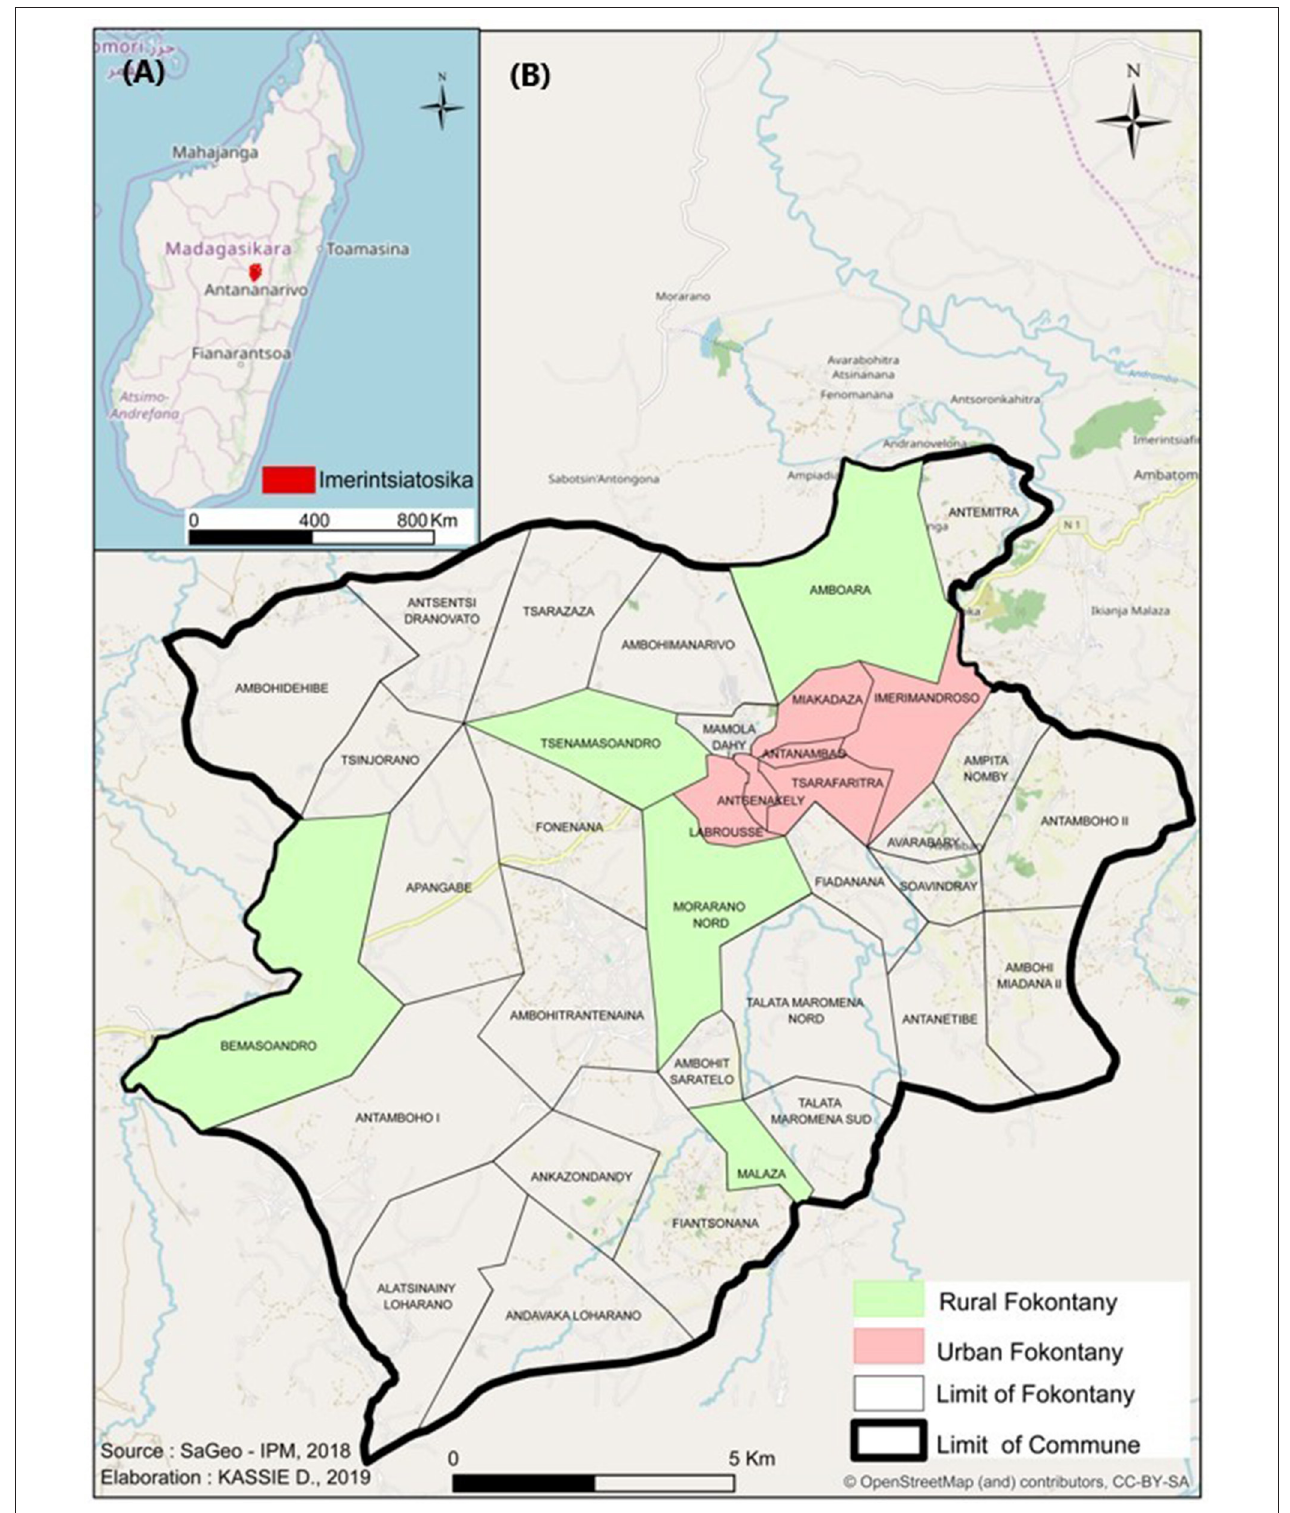
FIGURE 1 | Map of the study area in Madagascar (A) and Imerintsiatosika (B) . Red: urban studied fokontany; green: rural studied fokontany.